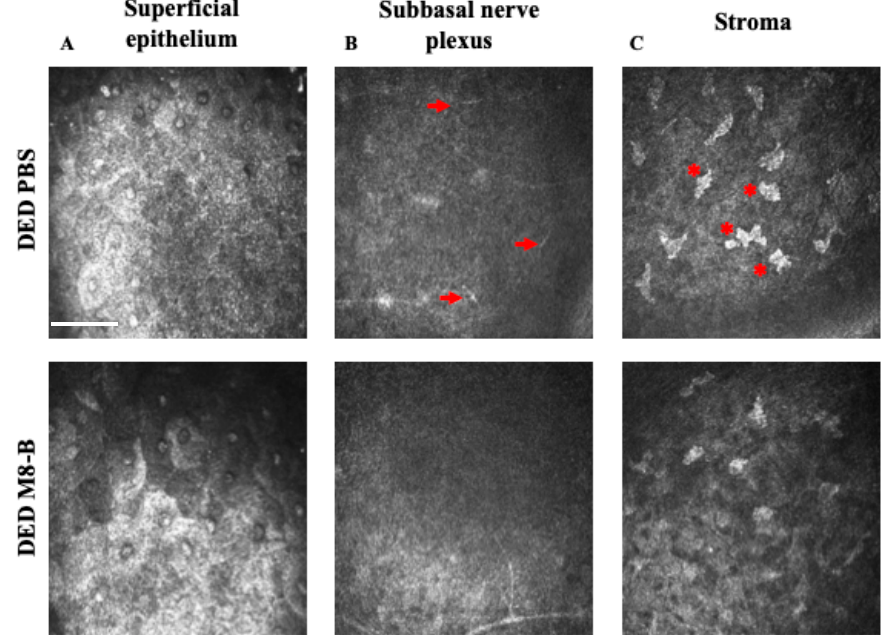
Figure 5. In vivo confocal microscopy images showing the different corneal layers from DED mice treated with 20 µM M8-B vs. PBS at day 21. ( A ) Corneal superficial epithelium, ( B ) corneal sub-basal nerve plexus (dendritic cells shown by red arrows), and ( C ) corneal stroma (activated cells shown red stars). Scale bar =100 µm.